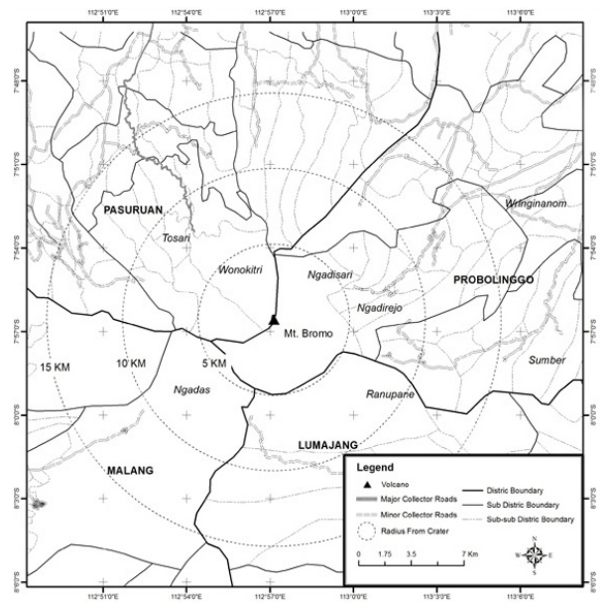
Figure 4. Map of surveyed villages in Bromo Volcano